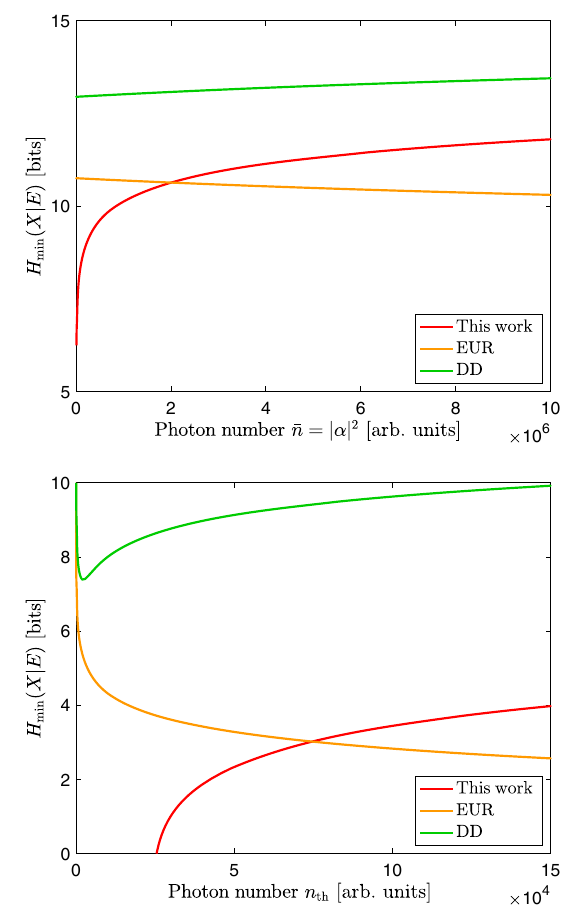
FIG. 5. Comparison between the conditional min-entropy per round with various nonvacuum input states for the present SDI protocol (red), protocols based on homodyning using an entropic uncertainty relation (EUR) for certification (orange), and device- dependent (DD) homodyning (green). The curves are plotted for different types of input states as a function of their mean photon number. Top: coherent state; bottom: thermal